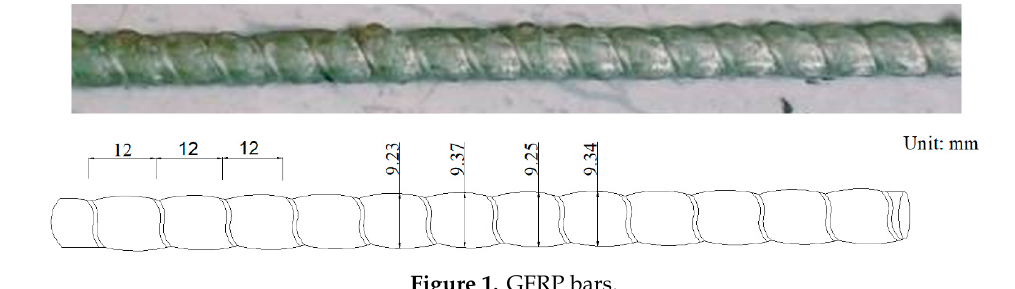
Figure 1. GFRP bars. Table 2. Tensile and physical properties of reference glass-fiber-reinforced polymer (GFRP)